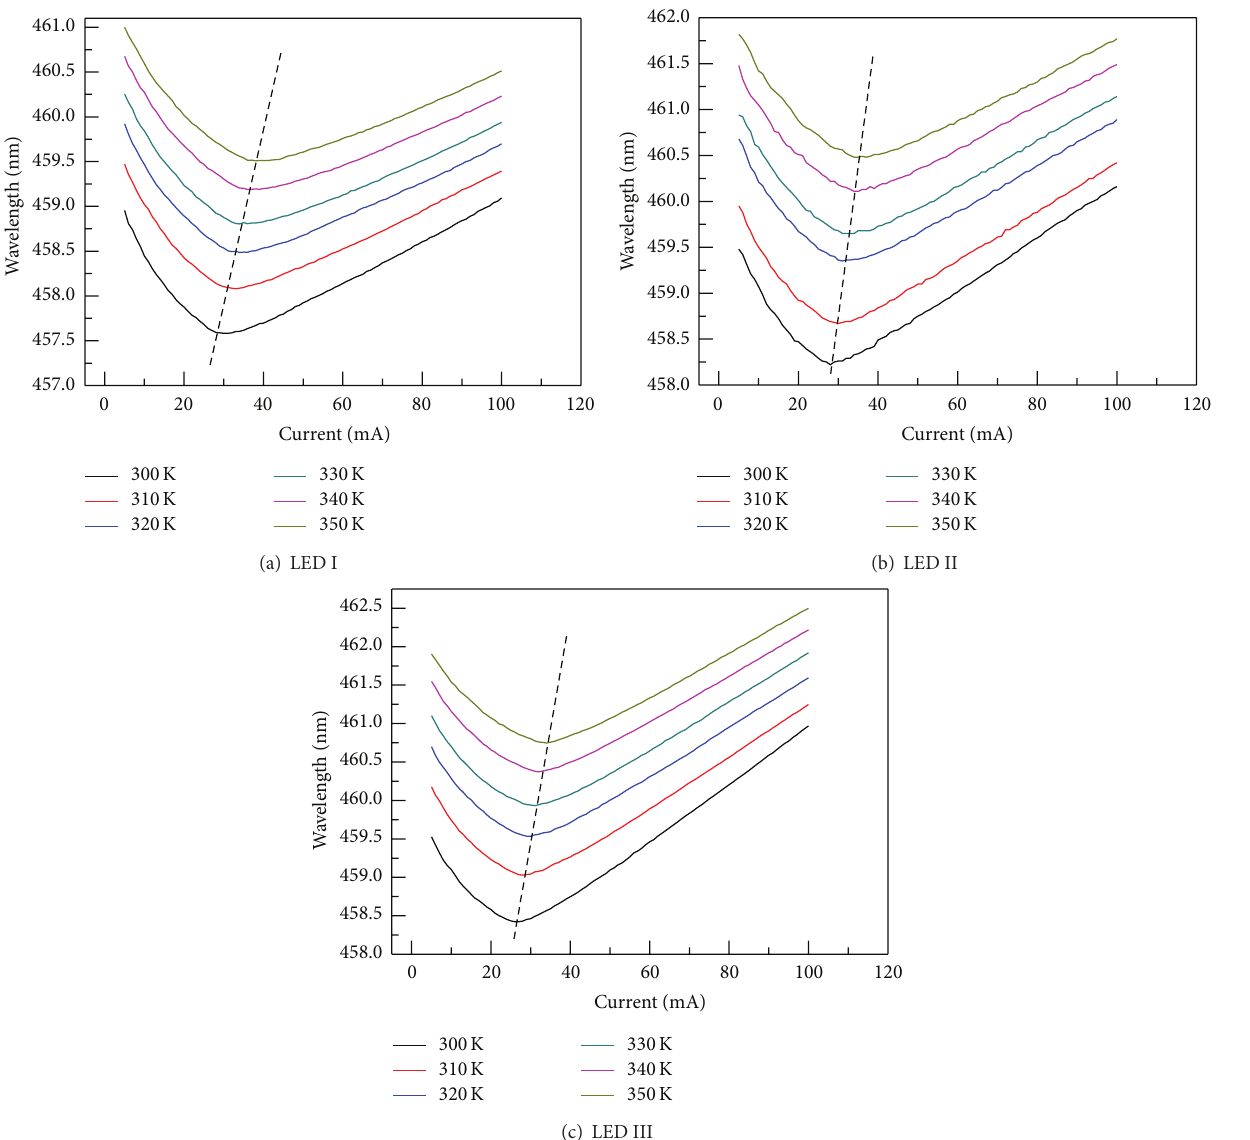
Figure 4: The emission wavelengths as functions of injection currents under different ambient temperatures measured from 300 to 350 K for (a) LED I, (b) LED II, and (c) LED